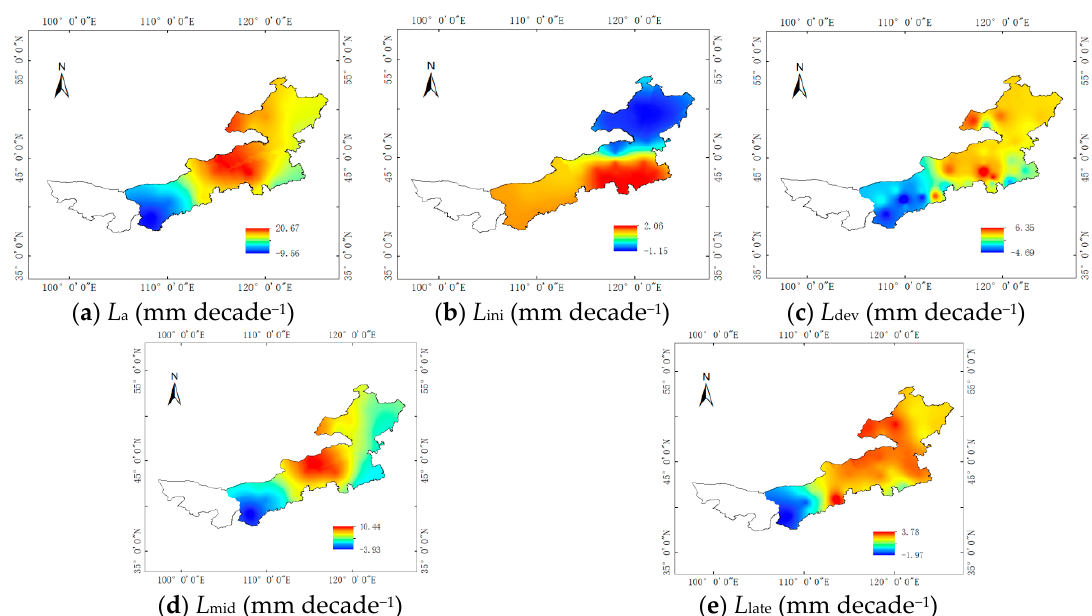
Figure 7. Spatial variation characteristics of I r during the entire growth period ( a ), early growth period ( b ), rapid growth period ( c ), middle growth period ( d ), and end growth period ( e ) of maize from 1959 to 2018.